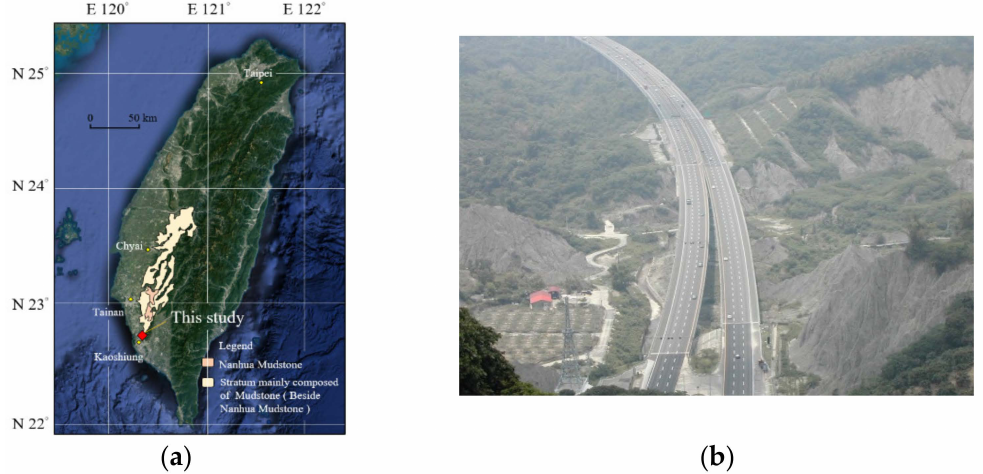
Figure 1. Distribution areas and bird view picture of mudstone in Taiwan: ( a ) The outcrops locations of mudstone (redrawn from Wang and Huang (2002)); ( b ) The famous badland slope situated along the northern exit of Chungliao